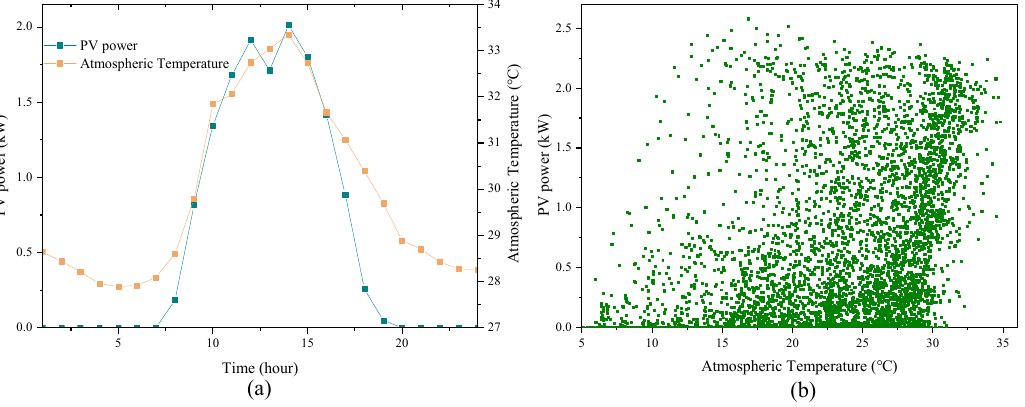
Figure 7. PV power and atmospheric temperature curves. ( a ) PV power and atmospheric temperature curves of a typical day; ( b ) correlation between atmospheric temperature and PV power.